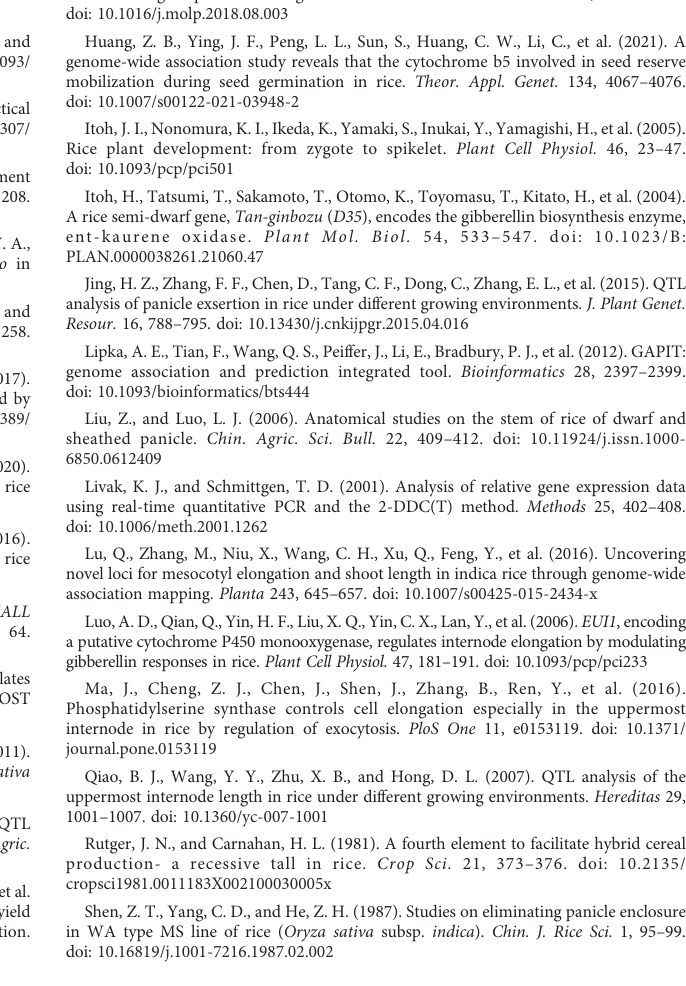
SUPPLEMENTARY FIGURE 1 Manhattan plots and quantile-quantile plots depicting the results of genome- wide association study for the panicle elongation length trait using a mixed line model in the rice population composed of 353 accessions in each environment. SUPPLEMENTARY FIGURE 2 Theallelefrequencyatthecausalpolymorphisms of PEL9 .TheGalleleindicates the type of reference allele. The T allele indicates the type of alternative allele. The sequence information of 446 wild rice and 392 Oryza sativa was downloaded from the website of and , respectively. WT, wild type; INDI, indica I; INDII, indica II; INDIII, indica III; TRJ, tropical japonica ; TEJ, temperate japonica